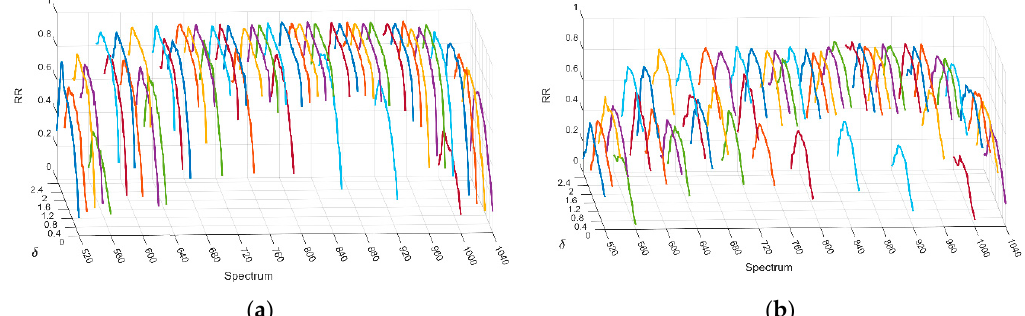
Figure 10. Recognition rates (RR) with different acutance TPVA on a single band of HDHV with different local texture patterns. Results using the feature extraction methods of ( a ) regional LBP; ( b ) deep features.